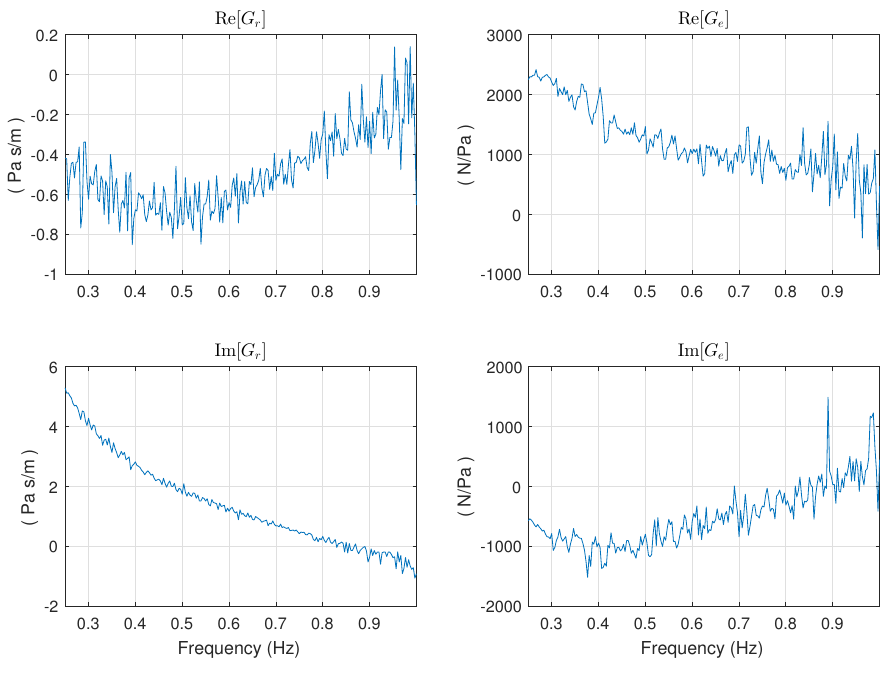
Figure 32. FRFs of the radiation and excitation models using pressure (from experiments 089 and 010